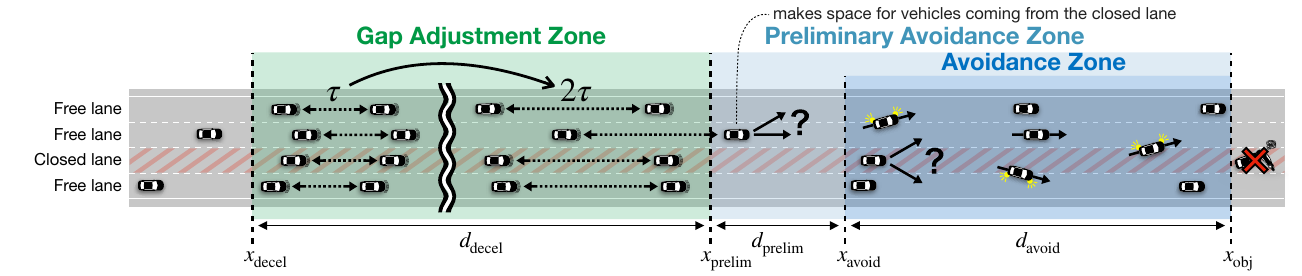
Figure 3. Control rules based on distance between an obstacle and approaching vehicles on a road with three or more